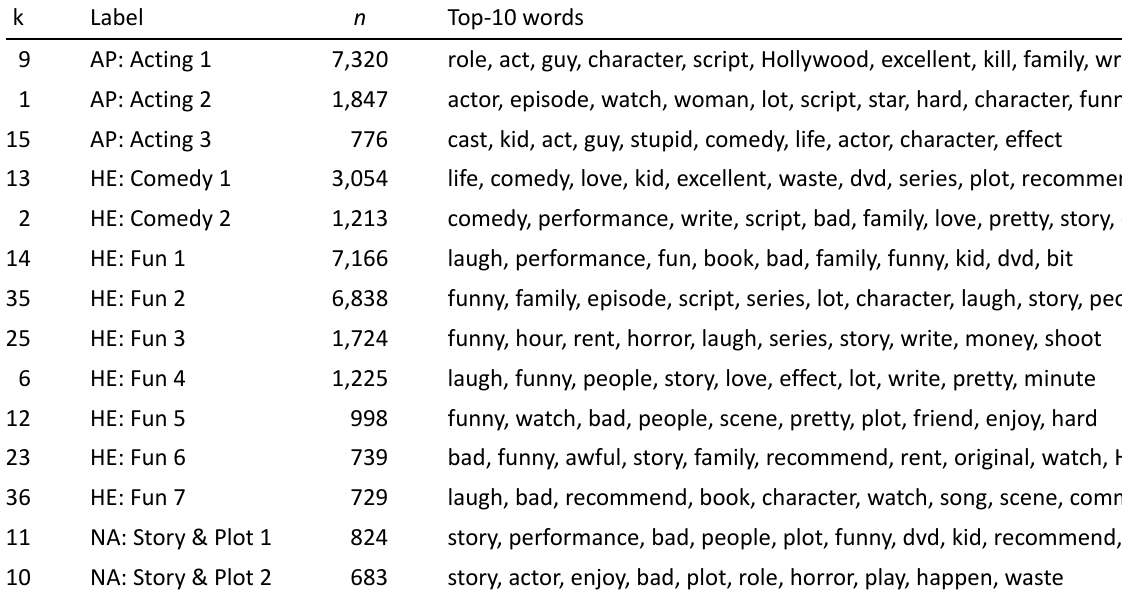
Table 1. CTM (k = 38, max. 1 topic/review, probability ≥ 0.02) with 14 manually selected topics with at least 600 reviews per review merged into three thematically overlapping topic categories, sorted alphabetically and by aggregated frequencies ( N =